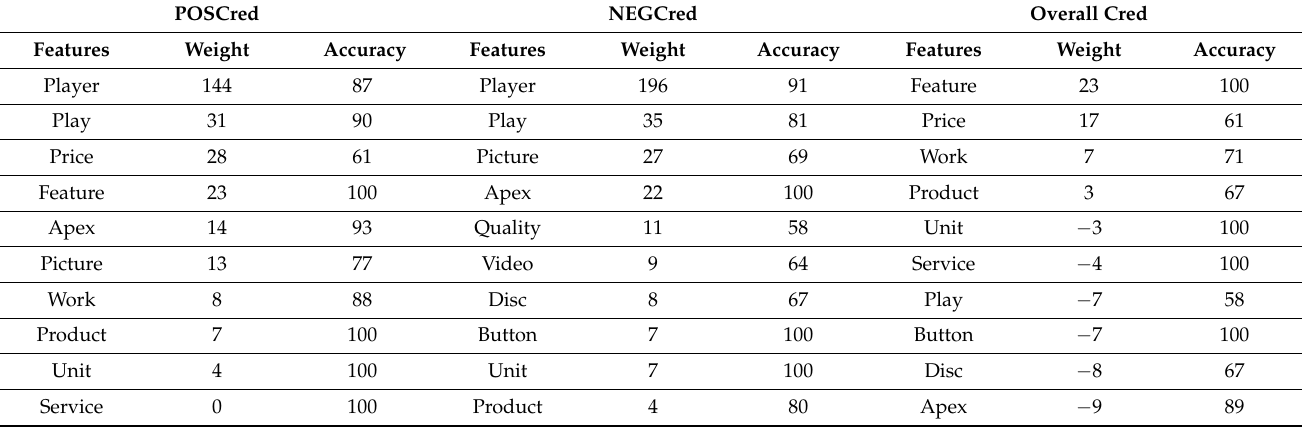
Table 5. POSCred, NEGCred, and OverallCred of top ten features of DVD